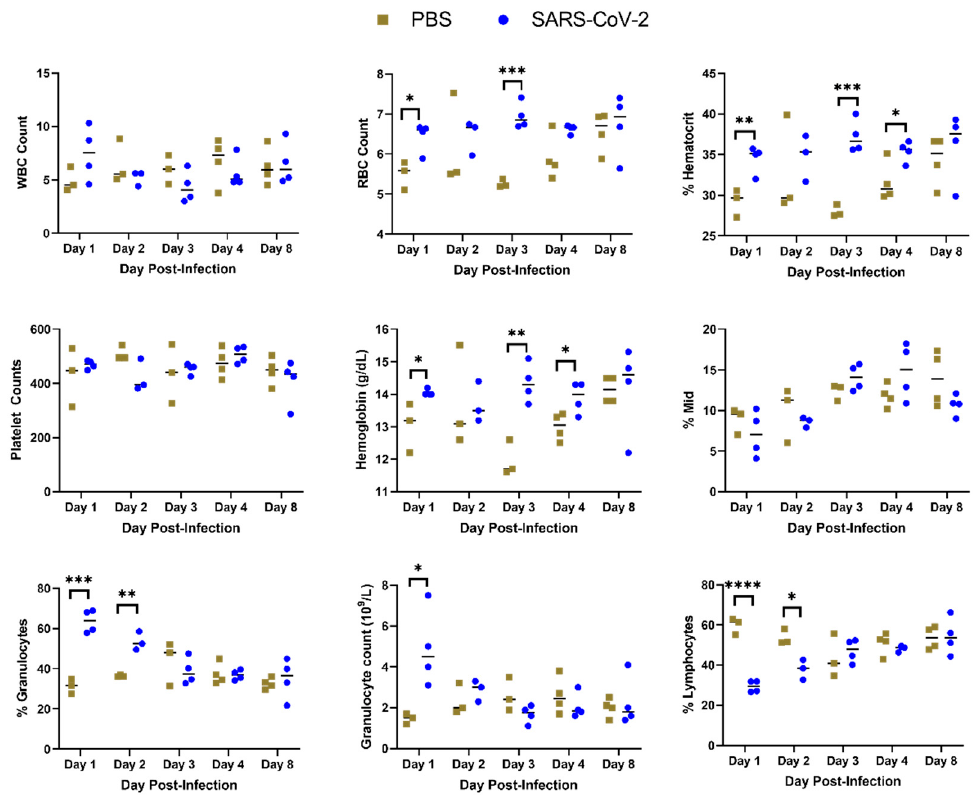
Figure 2. Complete blood count from hamsters infected with SARS-CoV-2 or sham inoculated